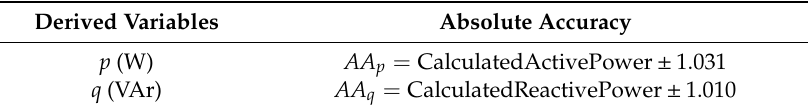
Table 18. Derived variables and absolute